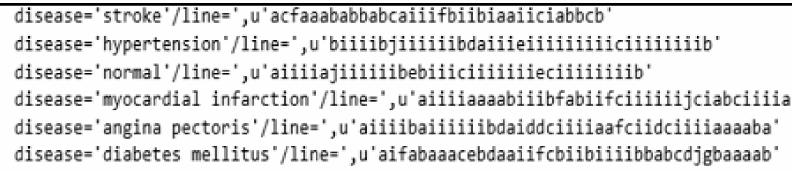
Figure 1. Data category configuration.